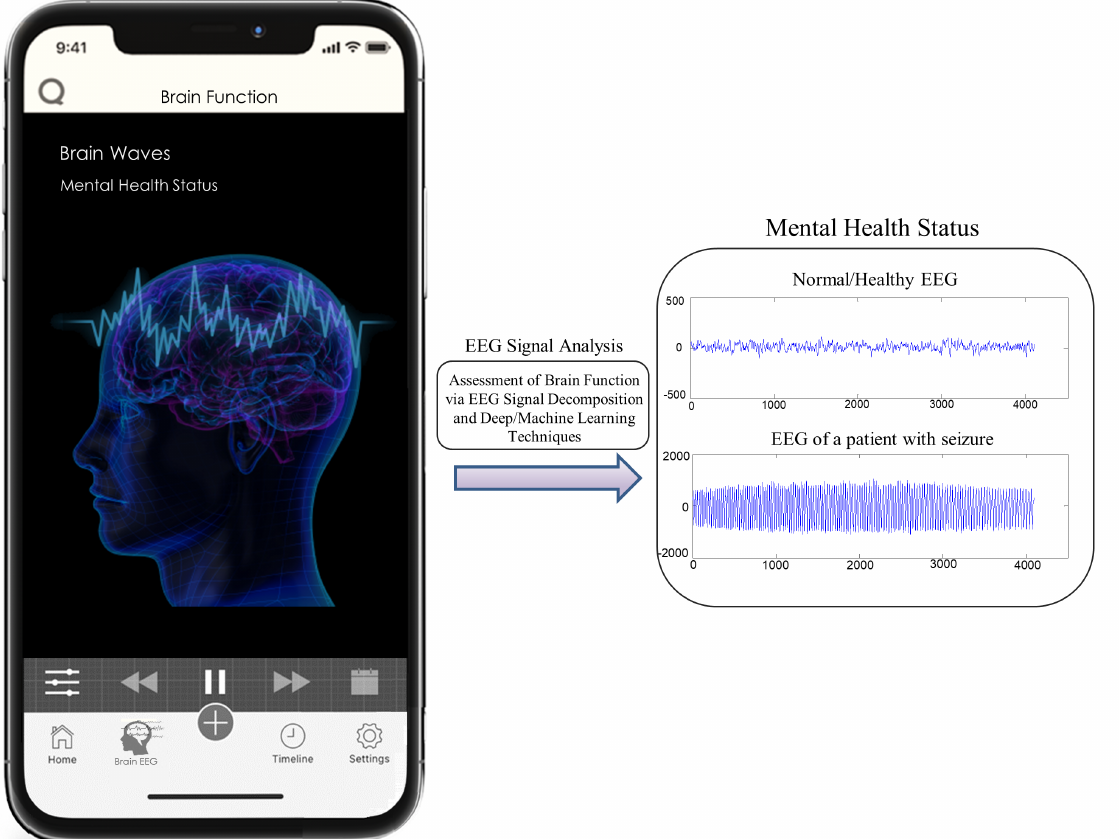
Figure 1. Brain function monitoring using EEG (Electroencephalography) analysis